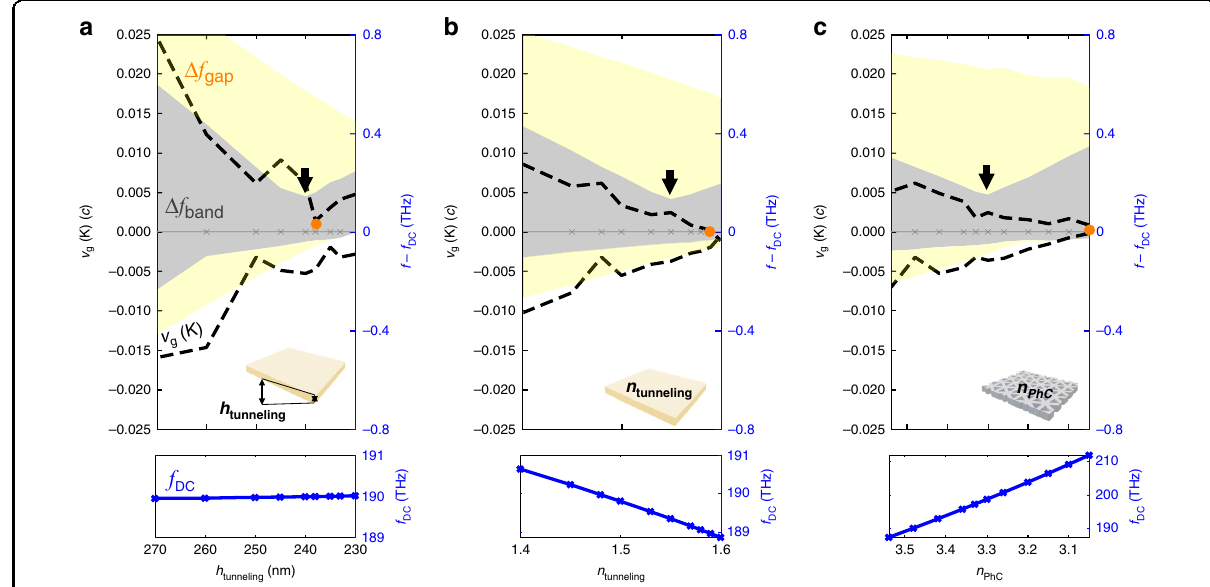
Fig. 5 Bandstructure engineering. a Top and bottom bandgap Δ f gap (yellow), bandwidth Δ f band (gray), group velocity at K point v g ð K Þ (black dashed line), and Dirac cone frequency f DC when changing a h , b n tunneling , and c n PhC . The narrowest bandwidth is pointed by the black arrow and the vanishing v g ð K Þ is labeled by the orange